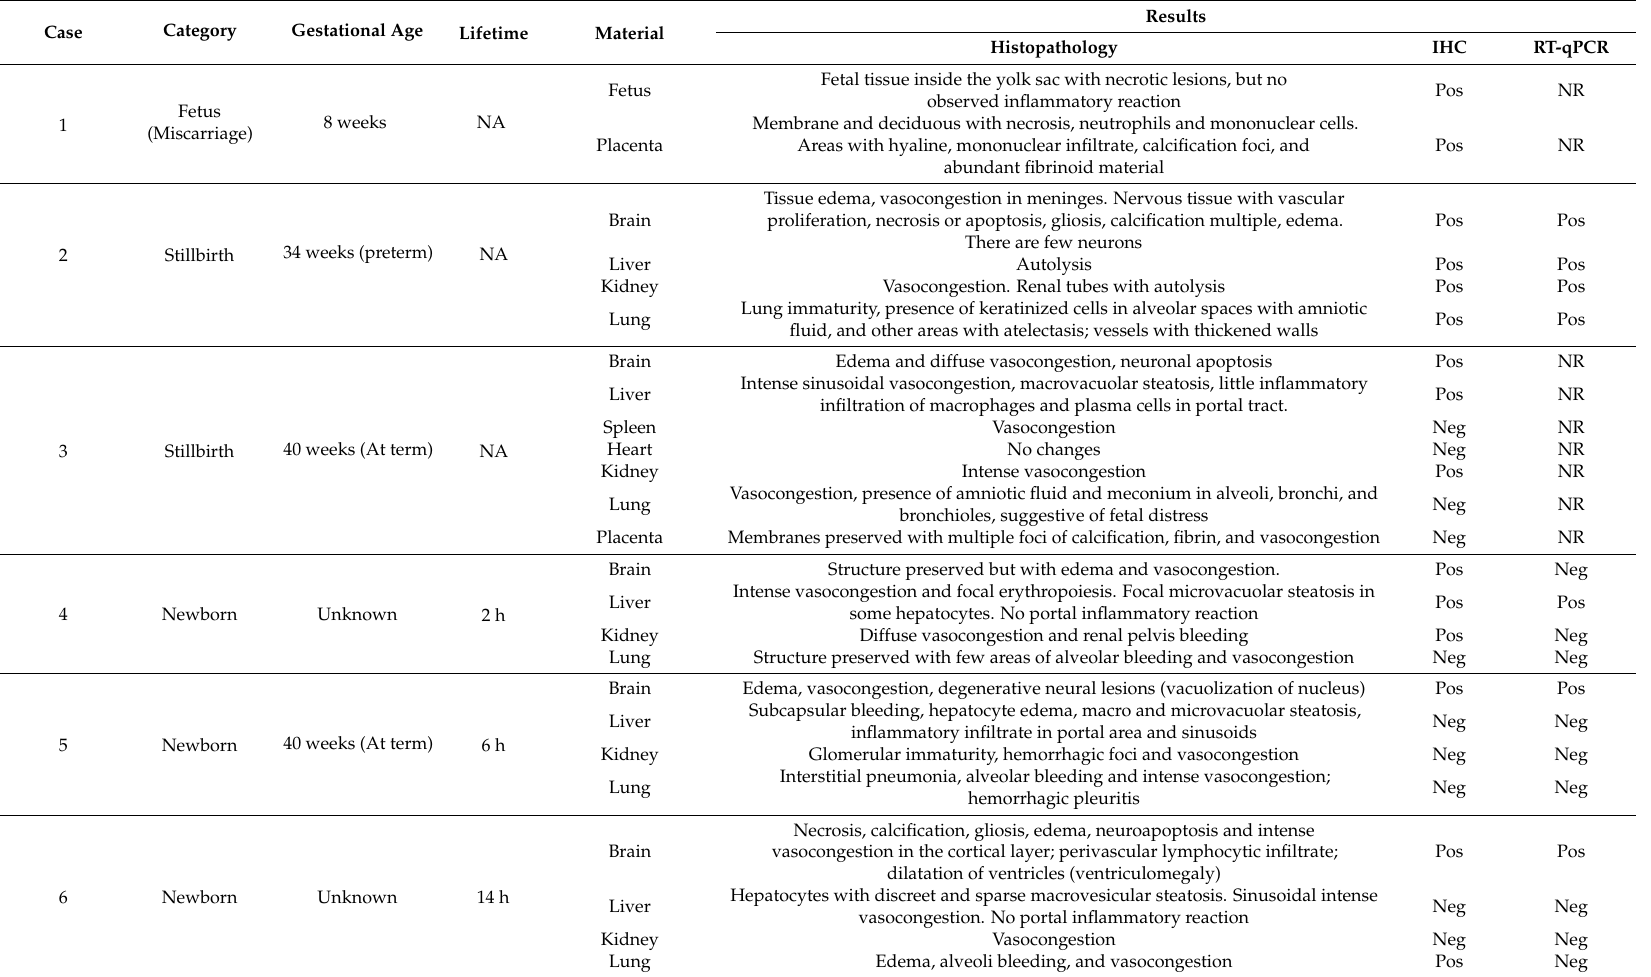
Table 2. Results of Histopathology, Immunohistochemistry (IHC) and Real Time PCR (RT-qPCR) in the 12 fatal cases of ZIKV